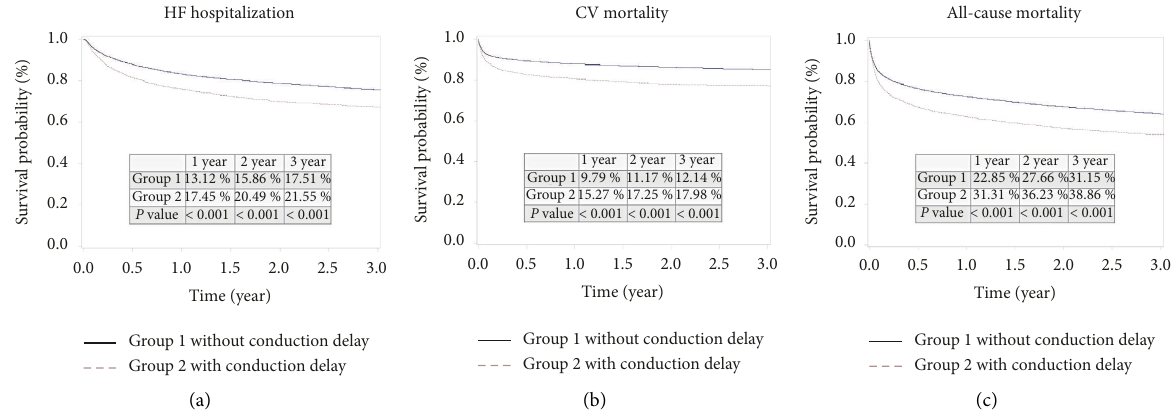
Figure 1: Kaplan–Meier curve analysis for heart failure (HF) hospitalization, cardiovascular (CV) mortality, and all-cause mortality in patients with or without conduction disorders during the 3-year follow-up period. (a): A higher incidence of HF hospitalization is noted in patients with conduction disorders. (with vs. without; 21.55% vs. 17.51%; p < 0 . 001). (b): A higher incidence of CV mortality is noted in patients with conduction disorders. (with vs. without; 17.98% vs.12.14%; p < 0 . 001). (c): A higher incidence of all-cause mortality is noted in patients with conduction disorders. (with vs. without; 38.86% vs. 31.15%; p < 0 .